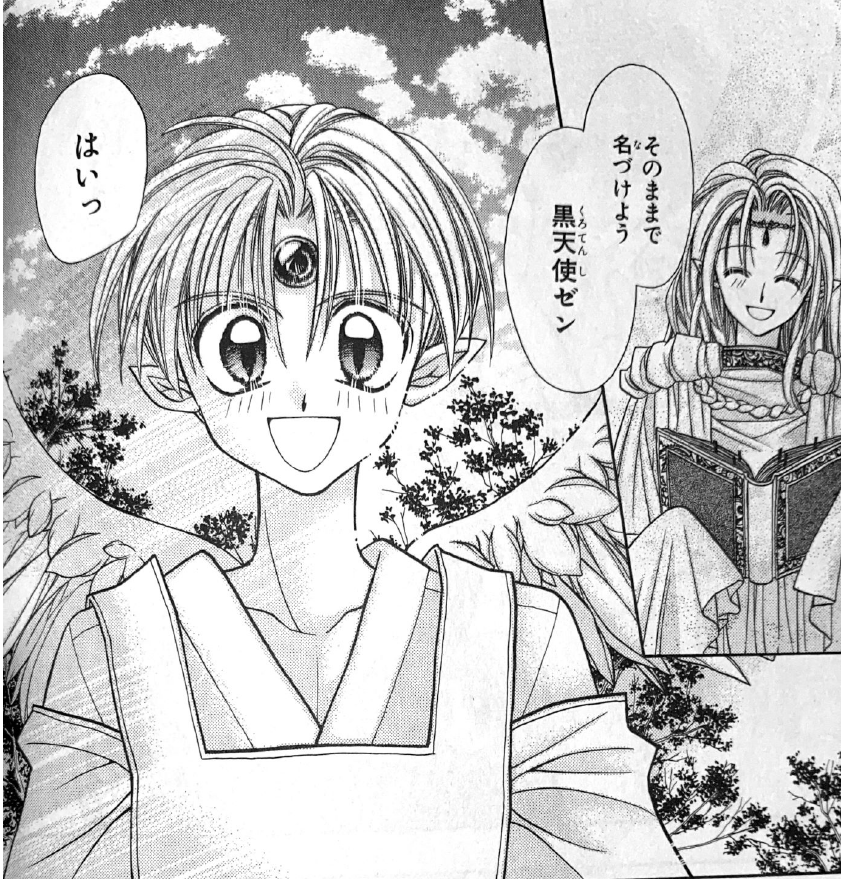
Figure 2 Black angel Zen and a great angel on the right side (Tanemura 2000a). The speech bubble on the right reads: “Let’s leave it that way and give you that name: Black angel Zen.” The speech bubble on the left reads: